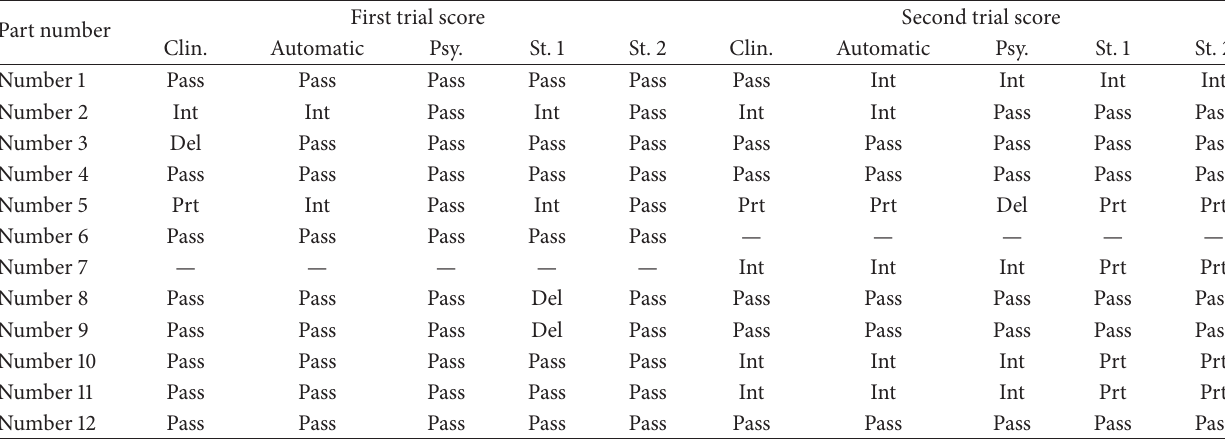
Table 3: Results of Visual Tracking task. Scores from the clinician (Clin.), automatic method (Automatic), a psychiatrist (Psy.), and two students (St. 1 and St. 2) for each trial. A trial is considered “passed” (Pass), “delayed” (Del), “interrupted” (Int), “partial” (Prt), or “no tracking” depending on how smoothly the child visually tracks the object.